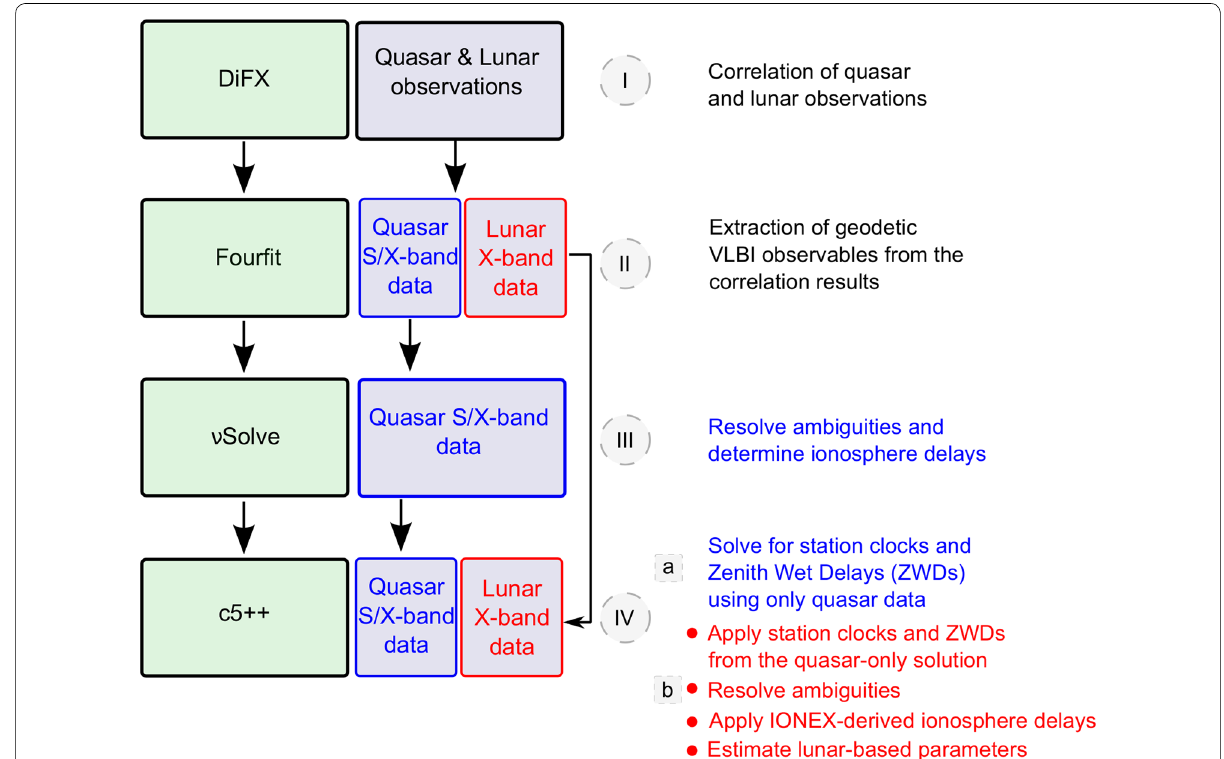
Fig. 2 Processing of quasar and lunar observations from the OCEL sessions. The schematics depicts a four-step processing chain used to obtain lunar geodetic VLBI observables and determine lunar-based parameters. All observations are correlated using DiFX 2.40 (Deller et al. 2011). The fringe search is performed using Fourfit for both quasar and lunar observations. In Step III, ν Solve (Bolotin et al. 2014) is used in order to resolve ambiguities and derive ionosphere delays for quasar observations. The parameter estimation is carried out in the last step where c5 et al. 2010) is utilized both for quasar and lunar